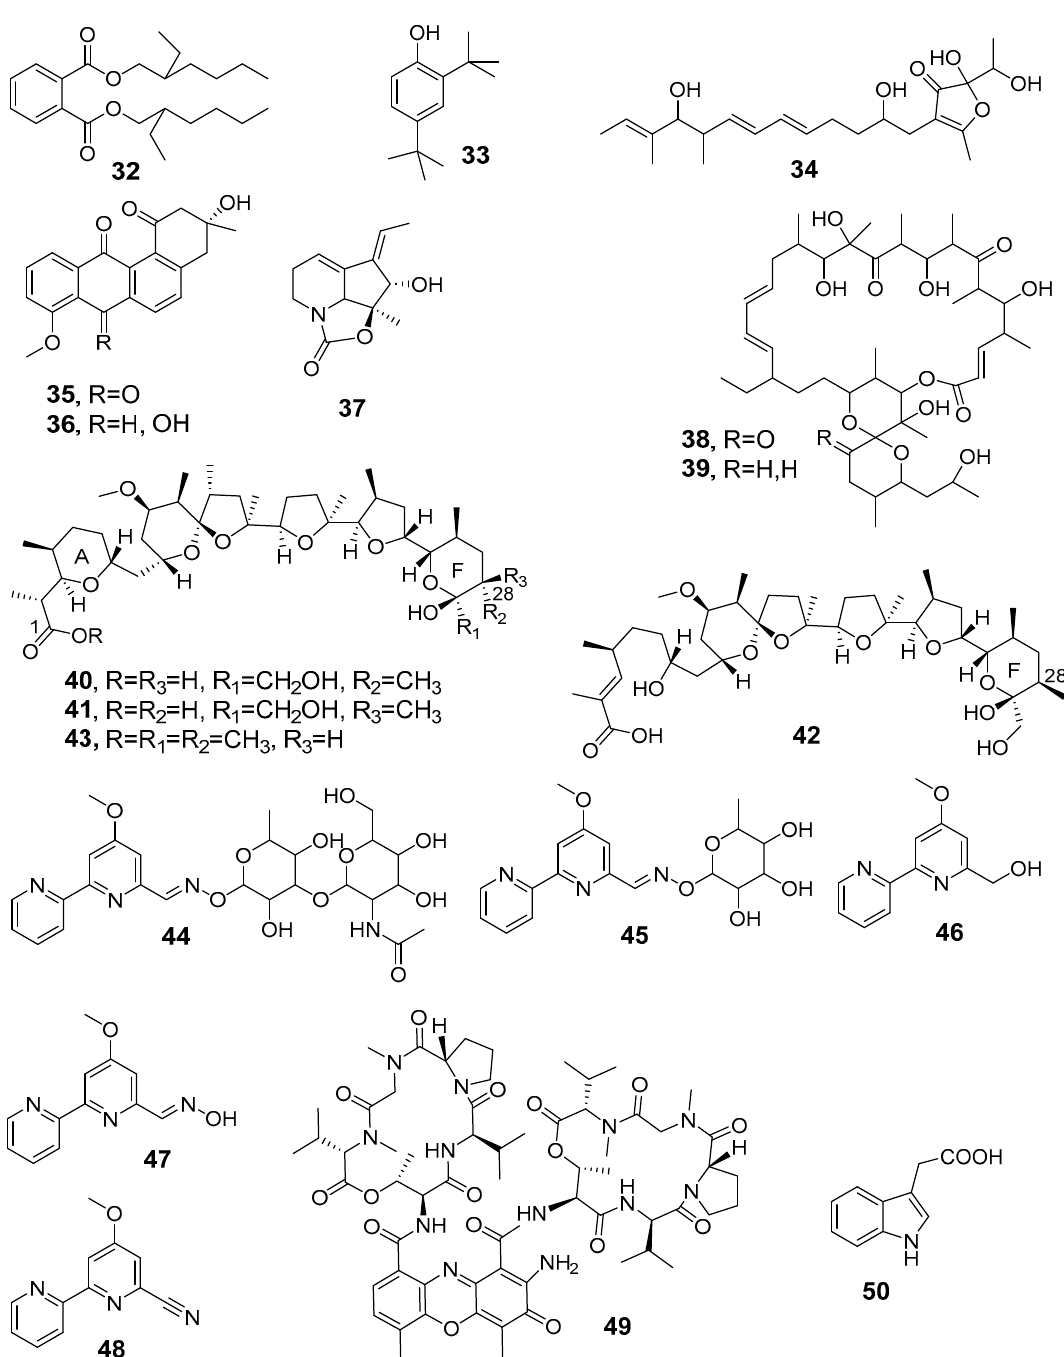
Figure 7. Molecular structures of the bioactive metabolites 32 – 50 isolated from Algerian actinobacteria. The stereochemical details are according the cited references.